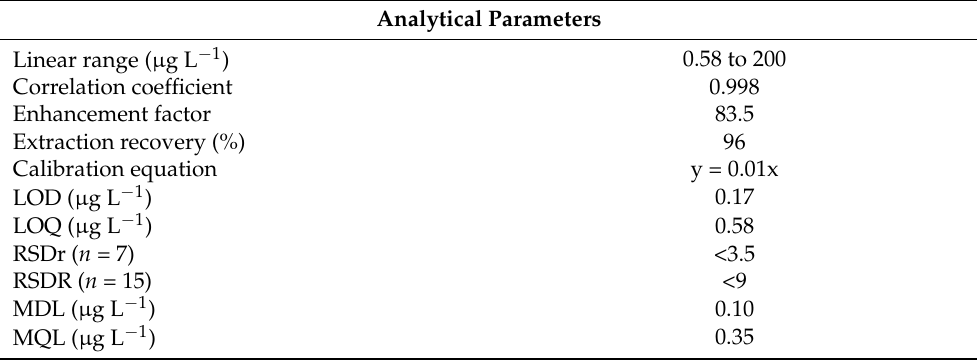
Table 4. Analytical figures of merit for Cd 2+ extraction followed by detection.